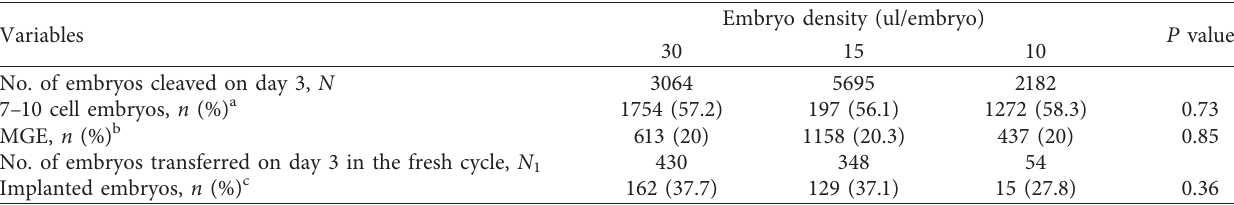
Table 2: Cleaving speed, quality, and clinical results of day-3 embryos among different embryo density groups ( n � 10941 for embryos cleaved on day 3; N 1 � 832 for embryos